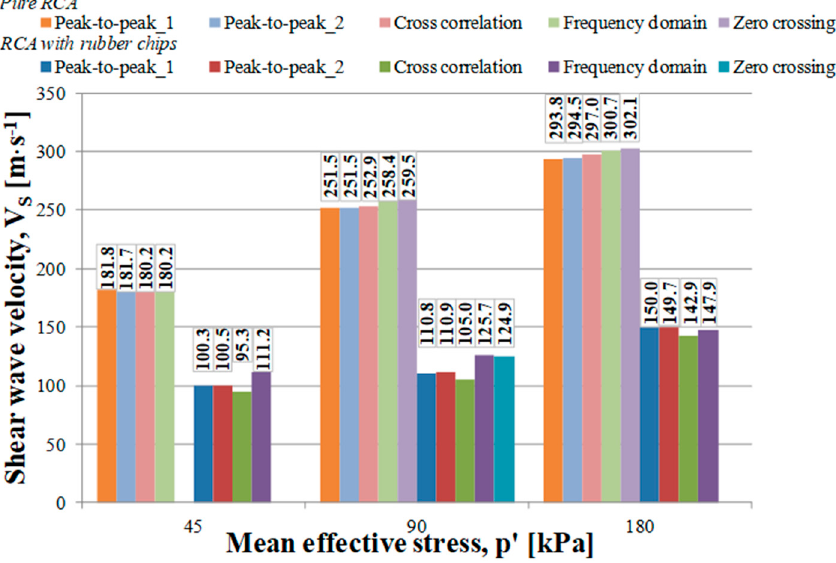
Figure 12. Comparison between selected V S values of pure RCA specimens and RCA with rubber chips compositions by four/five different methods of interpretation.